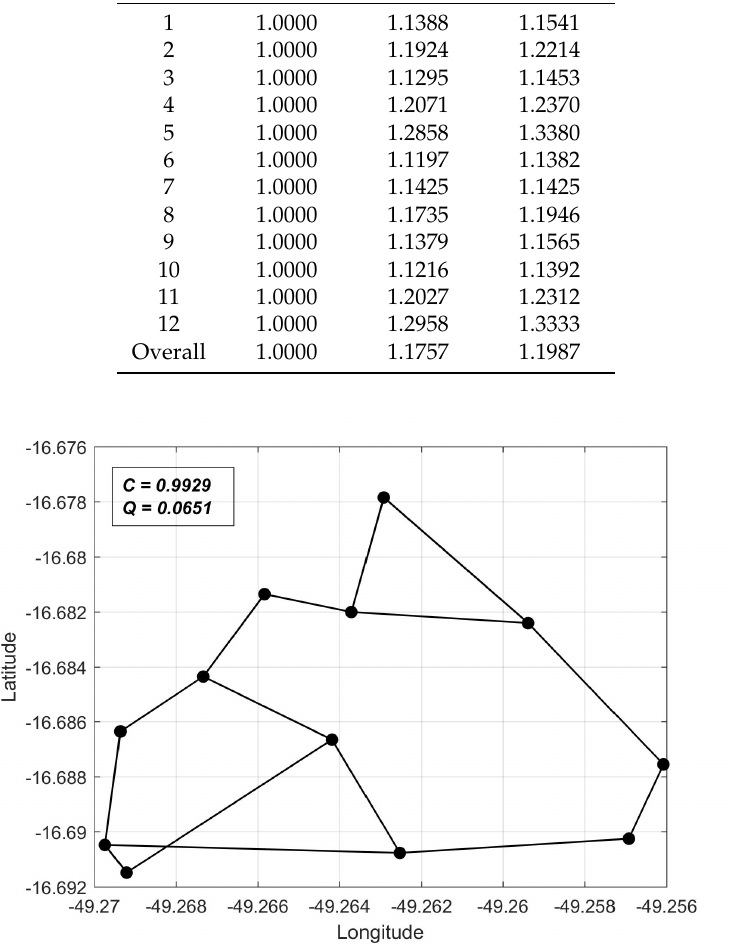
Figure 6. Solution P 1 obtained for r C = 0.8 and r Q =